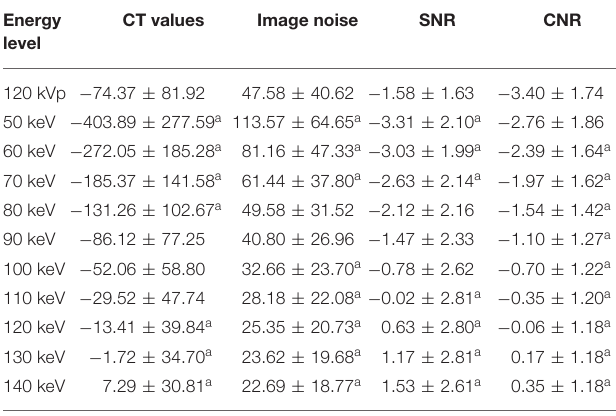
TABLE 4 | Objective image quality parameters.